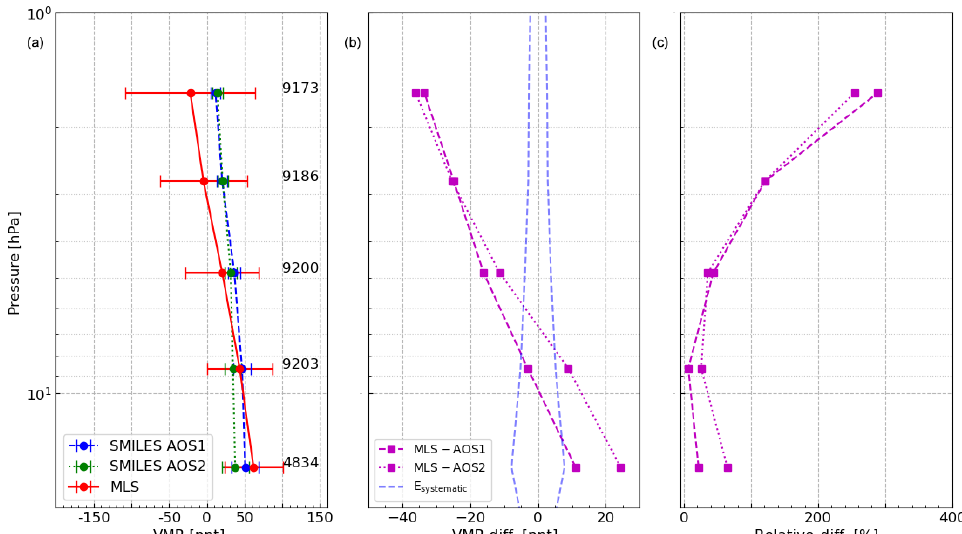
Figure 9. (a) Mean CH 3 CN VMR values and the standard deviations for SMILES and MLS measurements. The blue and green lines represent the SMILES VMR observed by AOS1 and AOS2, respectively. The red line represents the MLS VMR. Error bars indicate 1 σ standard deviation for each dataset. The number of coincident data are displayed at each point. (b) The absolute difference in the mean CH 3 CN VMR values between the SMILES AOS1, SMILES AOS2, and MLS observations is calculated by Eq. (11). Dashed blue lines indicate systematic errors theoretically derived in Sect. 3. (c) The relative differences between CH 3 CN levels observed using SMILES and MLS methods are calculated by Eq.